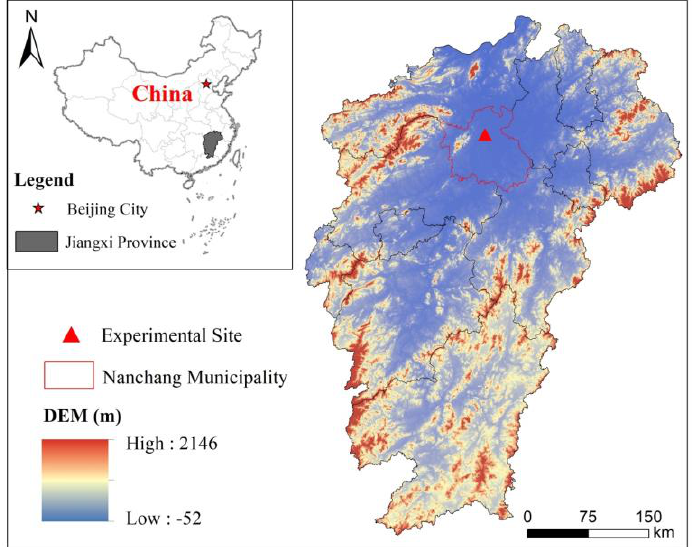
Figure 1. Location of the experimental site in Nanchang, Jiangxi, China. DEM means digital elevation model.